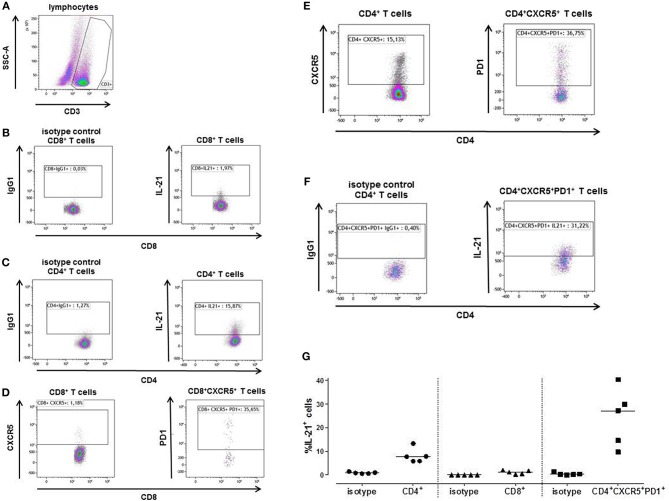
A typical example is depicted for intracellular IL-21 production after stimulation of patient's PBMCs with irradiated donor PBMCs depleted for CD3 (A). The proportion of IL-21 producing cells was determined after 3 days within the CD8+
(B) and CD4+ T cells (C). Tfh cells (CXCR5+PD1+) were determined within the CD8+
(D) and CD4+
(E) T cell population. The percentage of CD8+ Tfh cells was too low to be analyzed for IL-21. Within the CD4+ Tfh cells 31.22% produced IL-21 (F). The proportion of IL-21 producing cells was determined in PBMC samples from 5 kidney transplant recipients (G). The percentage donor-reactive IL-21 was determined in CD4+ and CD8+ T cells, and Tfh cells (CD4+CXCR5+PD1+). IgG1 isotypes are presented of each T cell subpopulations.